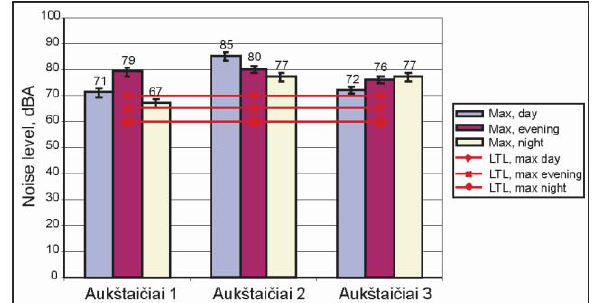
Fig. 15. Dynamics of maximum noise levels in Aukštaičiai street within twenty four hours